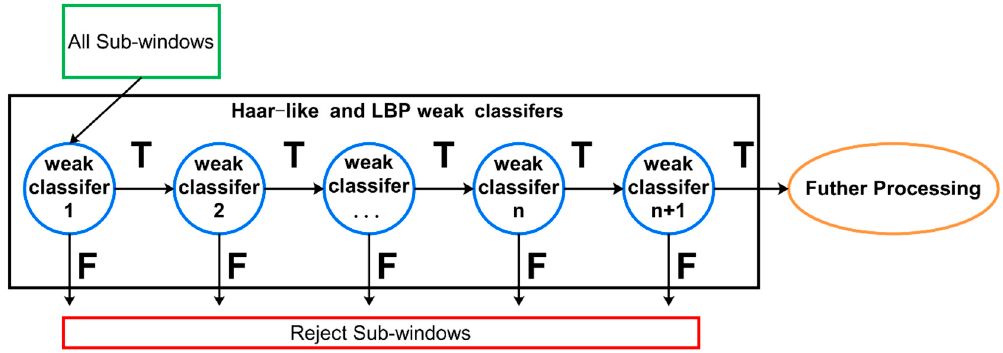
Figure 7. Schematic depiction of the detection cascade.